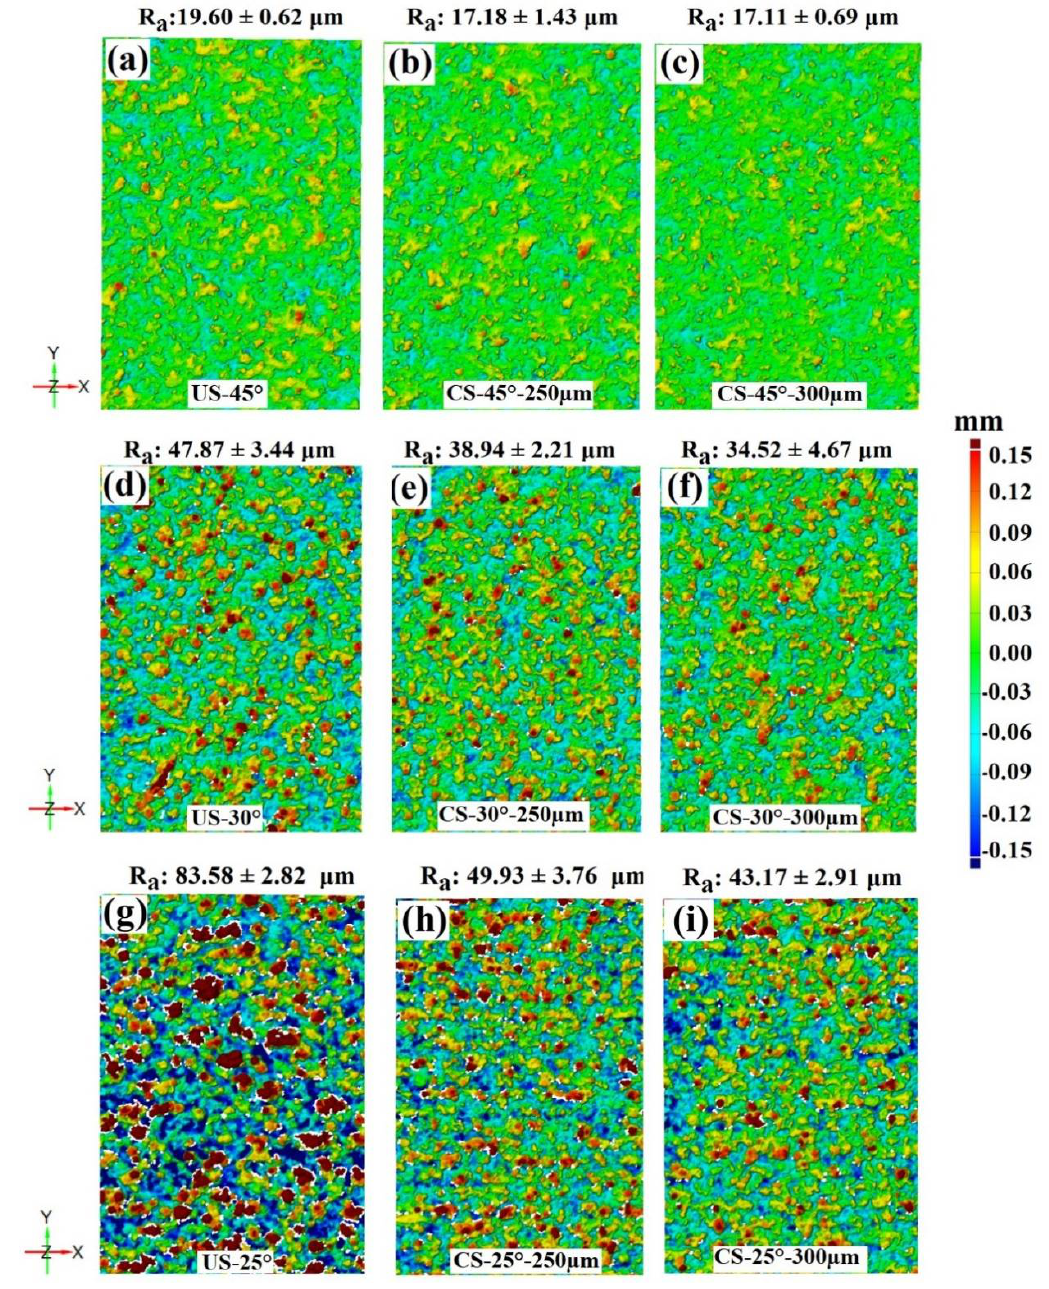
Figure 5. Surface texture maps derived from FV microscope images: ( a ) US-45°, ( b ) CS-45°-250 μm, ( c ) CS-45°-300 μm, ( d ) US-30°, ( e ) CS-30°-250 μm, ( f ) CS-30°-300 μm, ( g ) US-25°, ( h ) CS-25°-250 μm, ( c ) CS-45 ◦ -300 µ m, ( d ) US-30 ◦ , ( e ) CS-30 ◦ -250 µ m, ( f ) CS-30 ◦ -300 µ m, ( g ) US-25 ◦ , ( h ) CS-25 ◦ -250 µ m, and ( i ) CS-25°-300 μm. and ( i ) CS-25 ◦ -300 µ